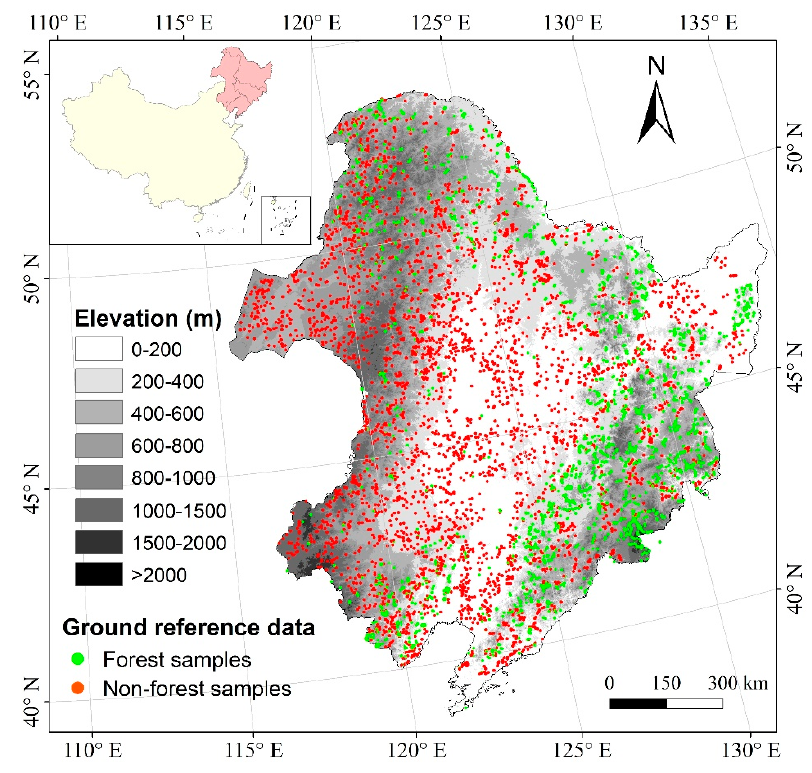
Figure 1. Location, topography, and ground reference data of study area.